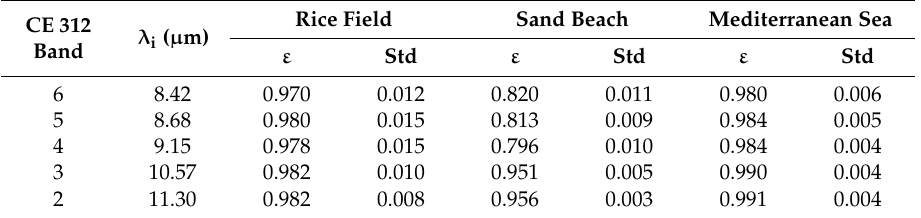
Table 4. Rice and sand beach emissivity values with their standard deviations (Std) retrieved from ground measurements using Temperature Emissivity Separation (TES) with CIMEL 312-2 and Mediterranean Sea emissivity using CIMEL CE312-2 and Negative Temperature Coefficient (NTC)